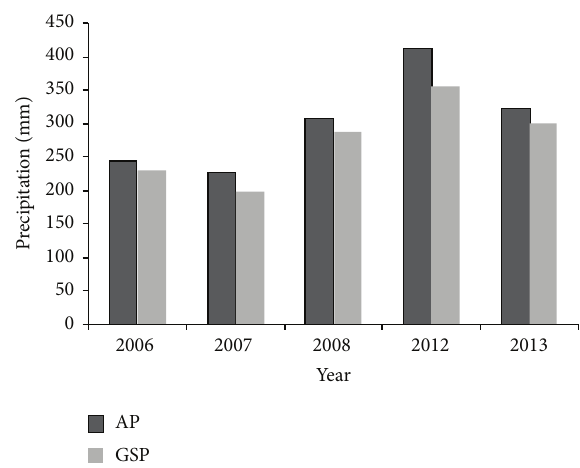
Figure 2: (AP) Annual precipitation (mm) growing season precip- itation (mm) (GSP) of the study site in 2006, 2007, 2008, 2012, and